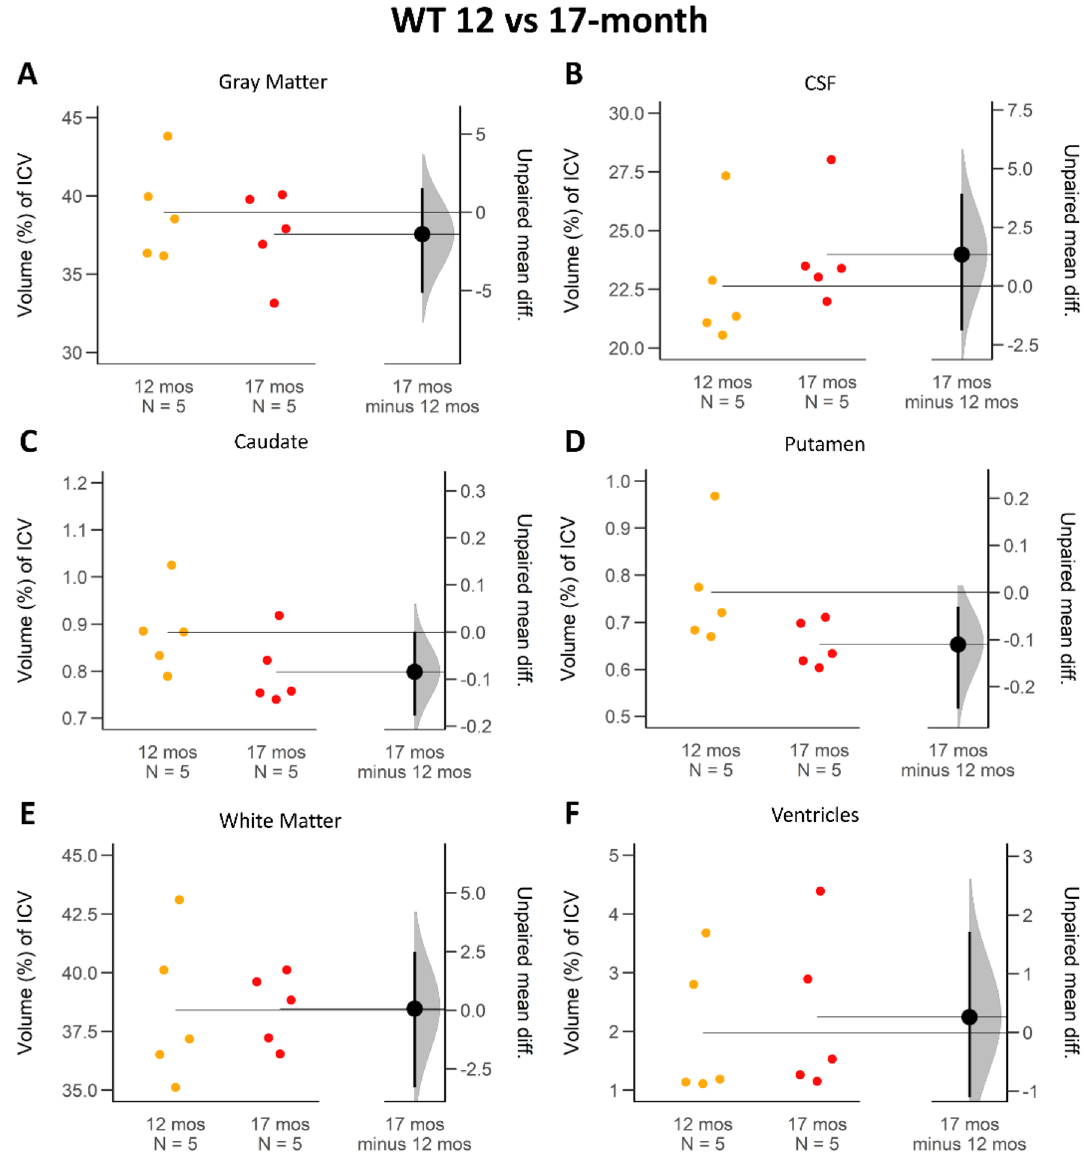
Figure 6. ICV proportion comparison of brain regions between 12- and 17-month-old WT miniswine. The average difference and 95% confidence interval (black circle with error bar in 17 mos minus 12 mos column ) do not cross the horizontal line at zero and indicates reliable measurement difference between the cohorts in the putamen ( D ). When the average difference and 95% confidence intervals (black circle with error bar in 17 mos minus 12 mos column) cross the horizontal line at zero as it does for gray matter ( A ), CSF ( B ), caudate ( C ), white matter ( E ) and ventricles ( F ), an effect size equal to zero is possible, and reliable measured difference is